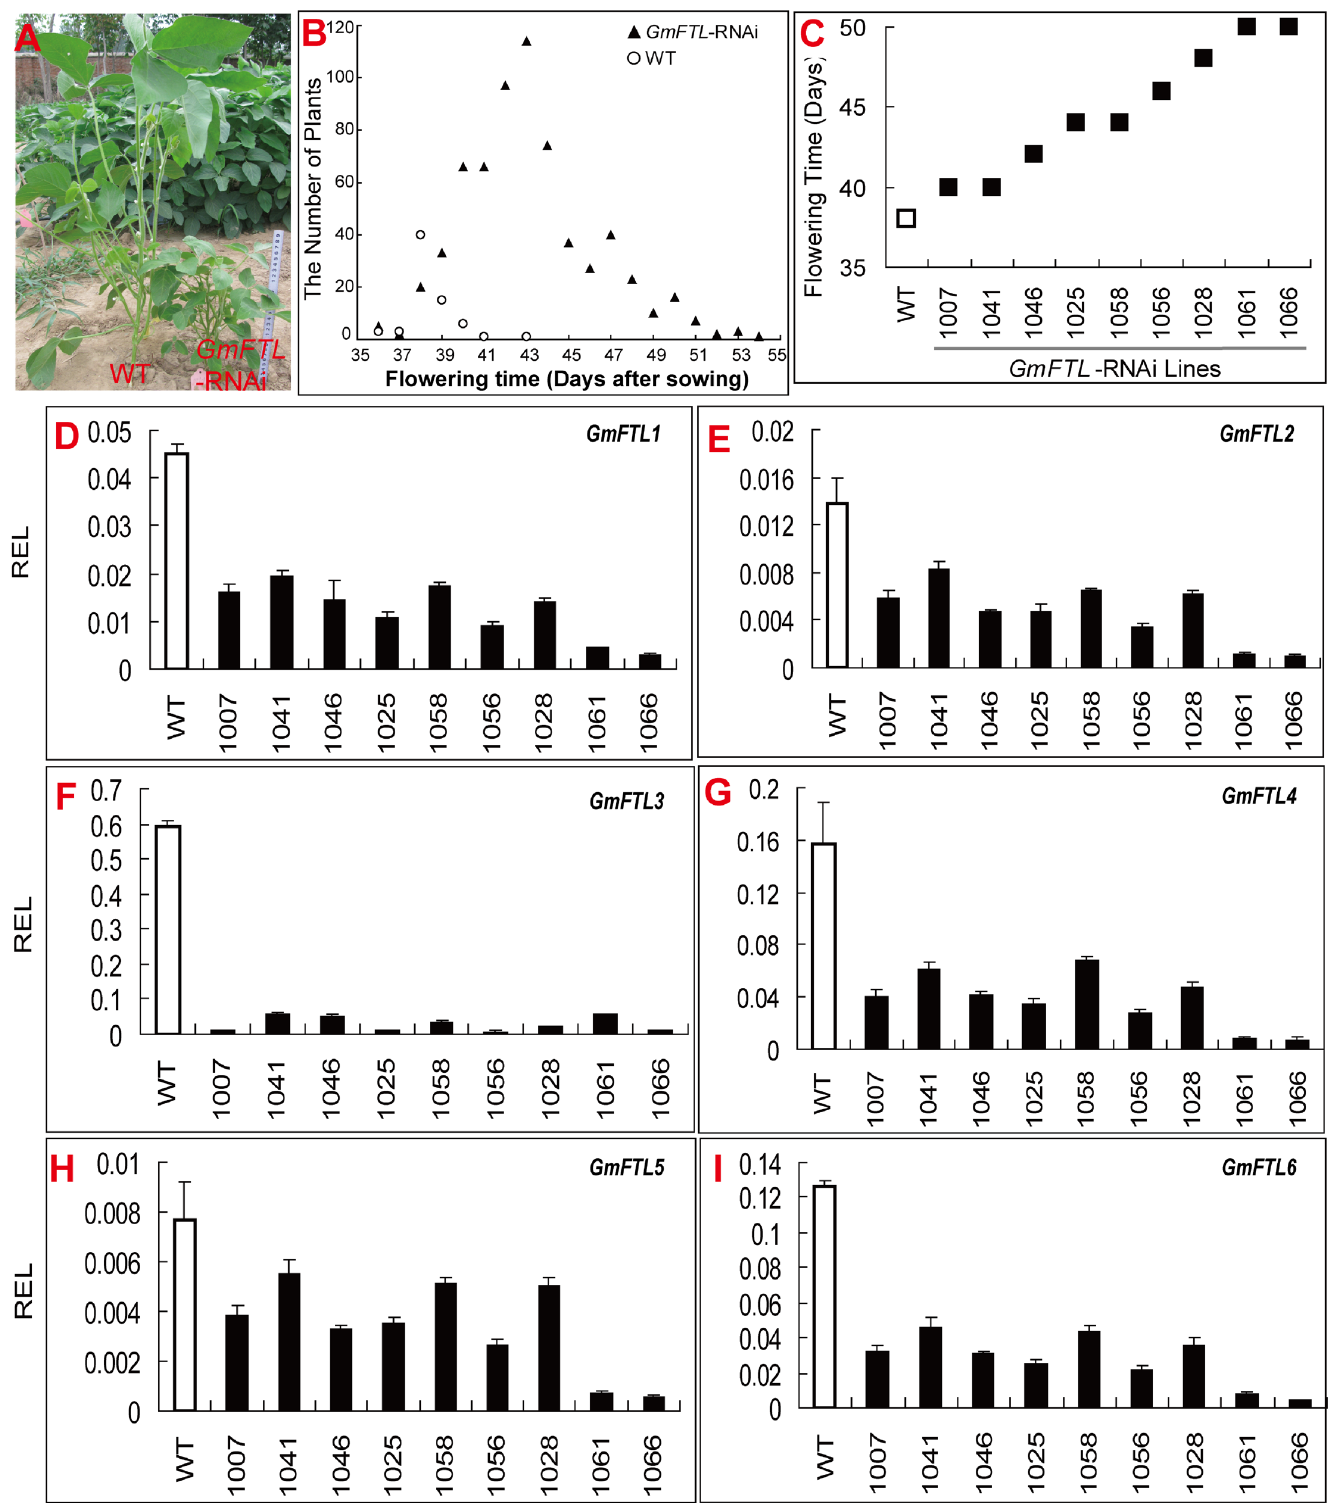
Fig 10. Silencing GmFTL s delays flowering and inhibits growth. (A) A GmFTL -RNAi transgenic (right) and wild type (left) soybean plants grown in the field for 40 days. (B) Flowering time of transgenic lines. The total number of plants: WT, 69; Transgenic lines, 643. (C) The flowering time of transgenic lines used for analysis of GmFTL relative expression level (REL, D to I). (D to I) Endogenous GmFTL relative expression level in GmFTL silencing lines.